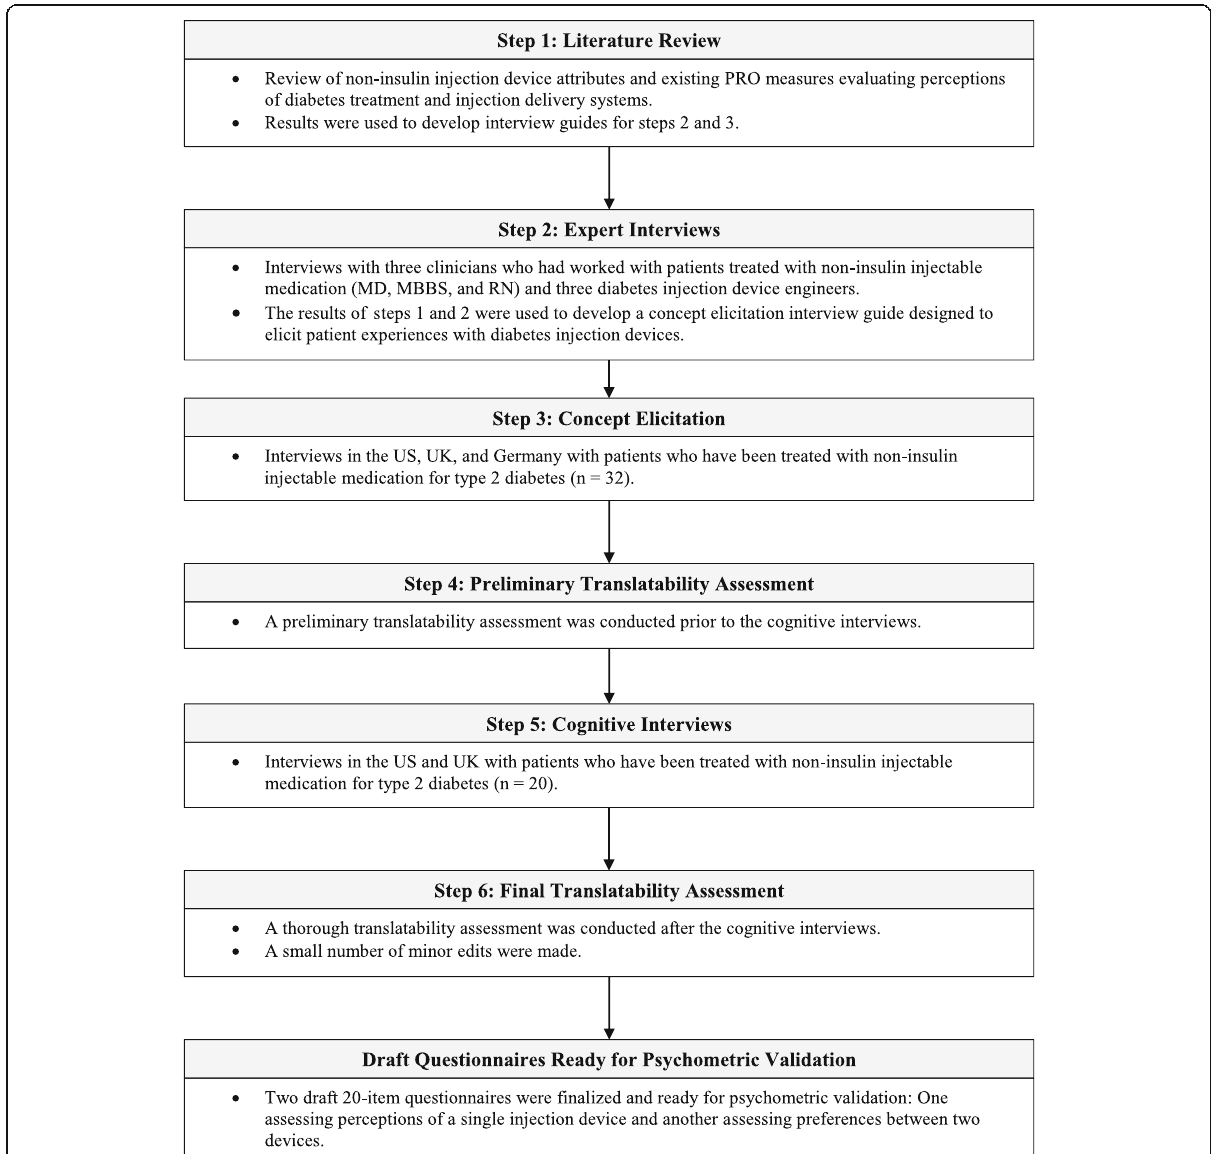
Fig. 1 Summary of Instrument Development for the Diabetes Injection Device Experience Questionnaire and Preference